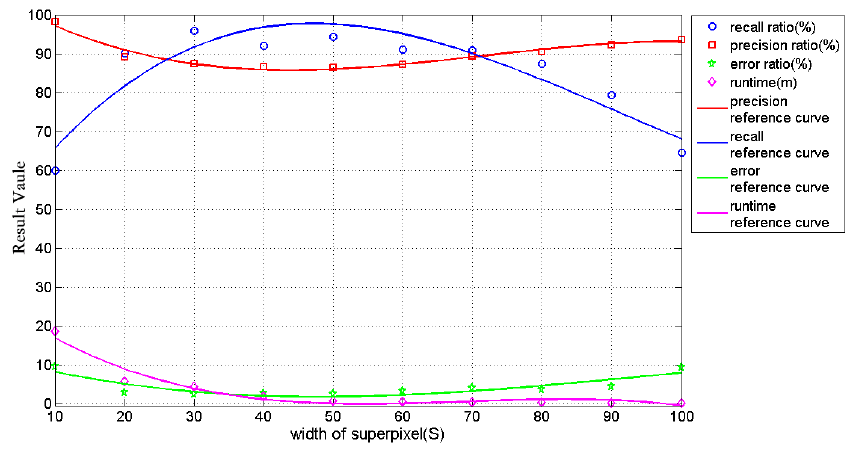
Figure 14. Effects of parameter S for cloud detection.